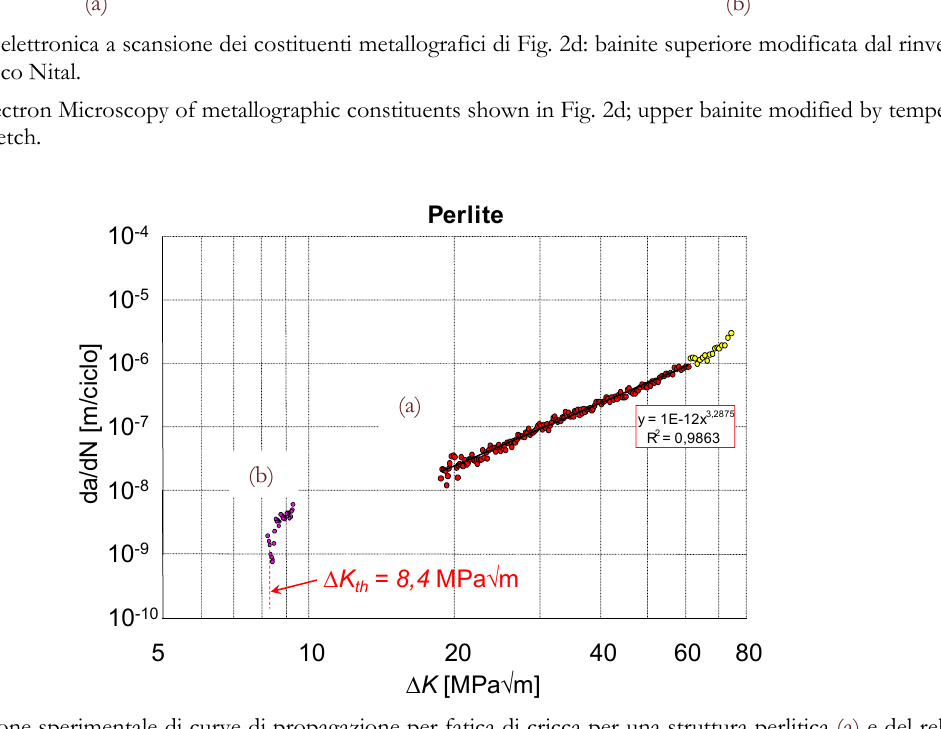
Figura 4: Determinazione sperimentale di curve di propagazione per fatica di cricca per una struttura perlitica (a) e del relativo valore di ∆ K di soglia, ∆ K th (b) ( R = 0,1). Figure 4: Fatigue crack propagation rate (a) and threshold ∆ K , ∆ K th (b) in a pearlitic microstructure (R=